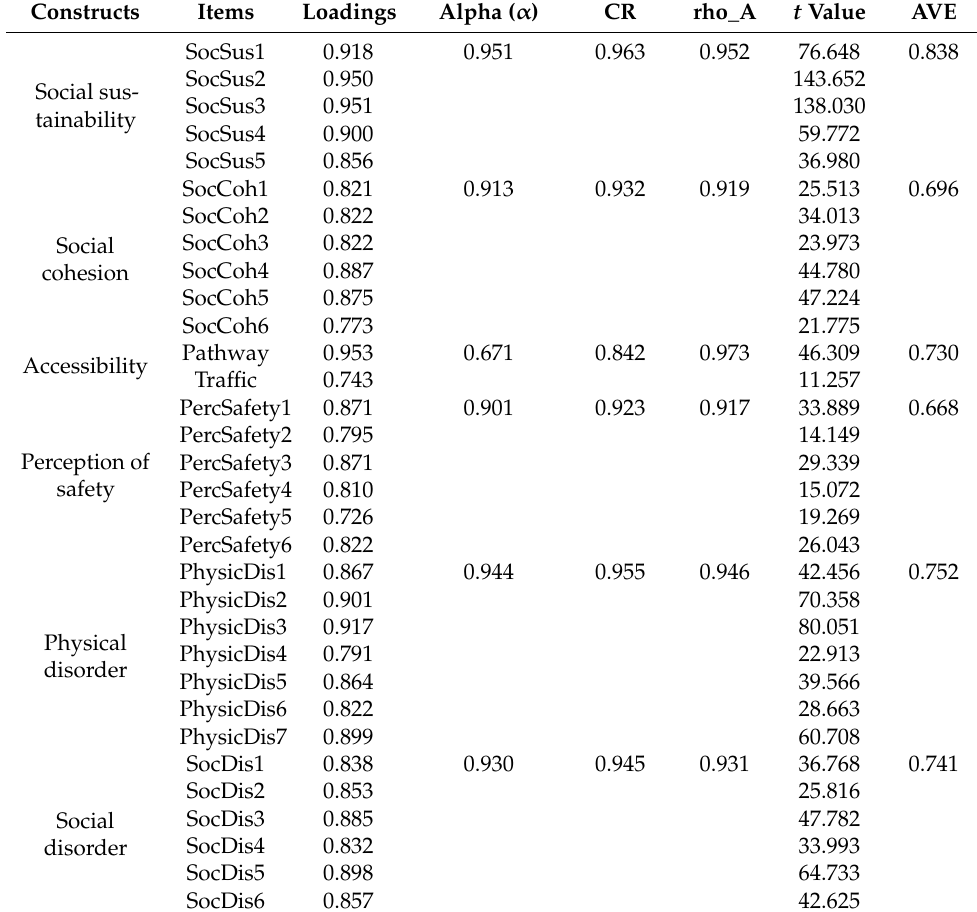
Table 1. Measurement model results for the latent constructs.